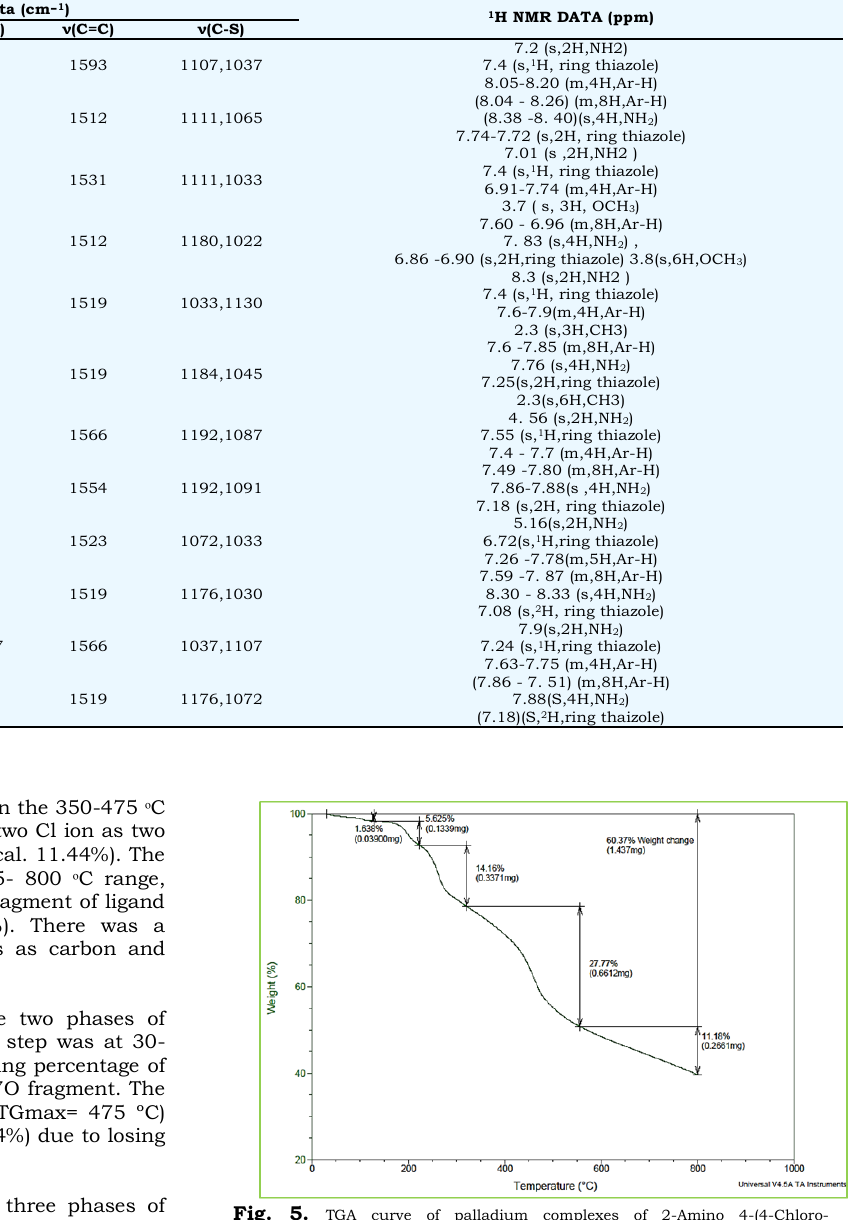
Table 2 Important IR and 1 HNMR data for2-Amino 4-(4-substitutedphenyl) thiazole derivatives ligands and their palladium complex Comp.